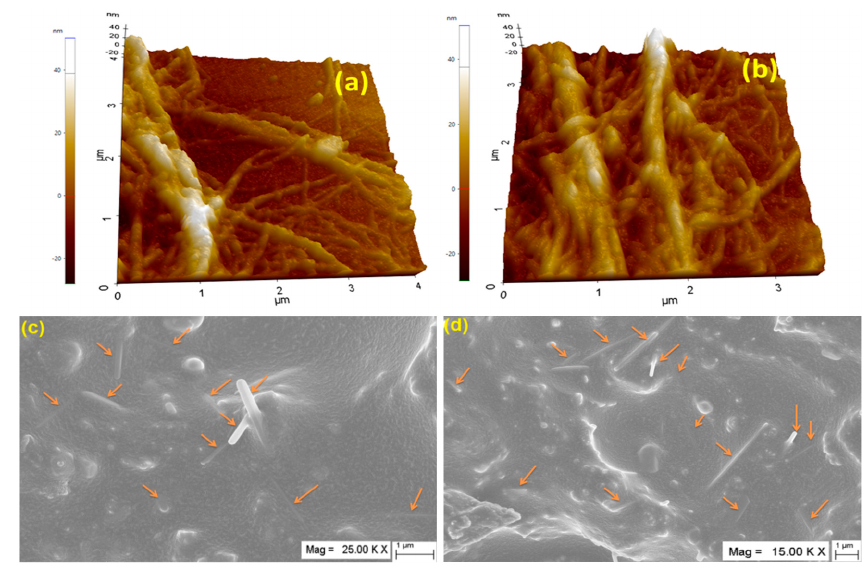
Figure 4. ( a , b ) AFM images of PMF-20/CNF composite with 10 and 25% ( v / v ) CNFs; ( c , d ) SEM images of PMF-20/CNF composite with 10 and 25% ( v / v ) CNFs.